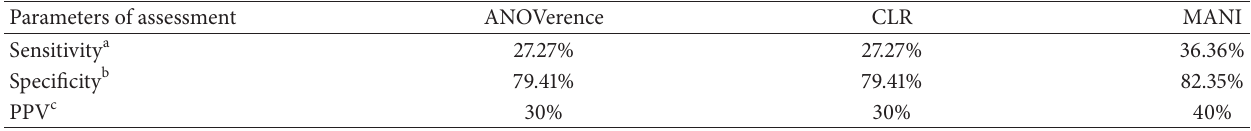
Table 2: Network inference performance of MANI and other